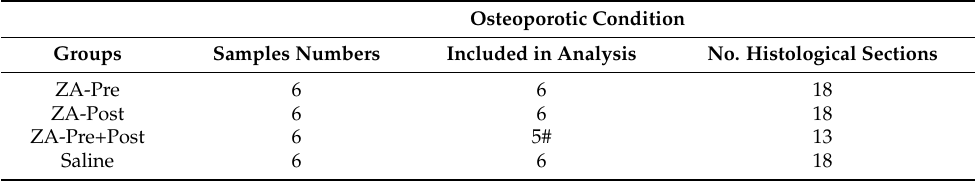
Table 1. Number of samples used for histological evaluation and histomorphometric measurements.